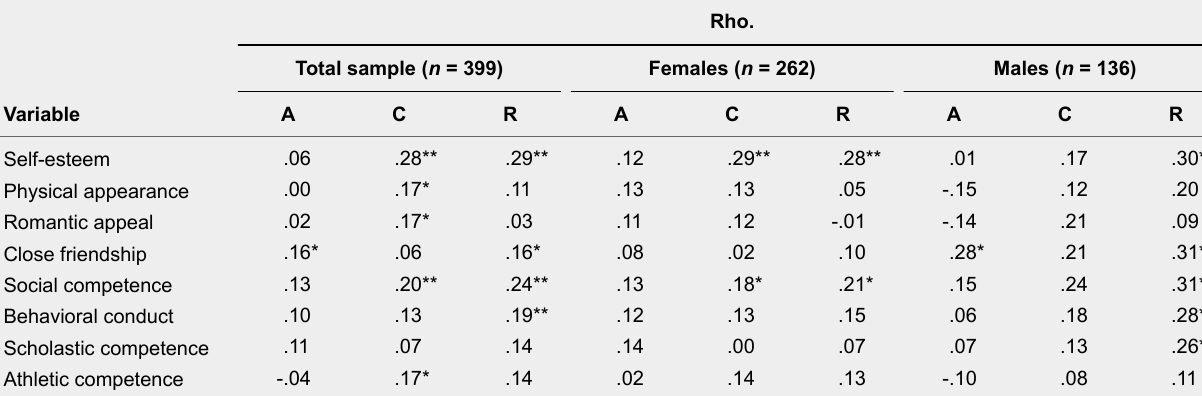
Correlations Between Self-Esteem and Self-Concept and Emotional Intelligence